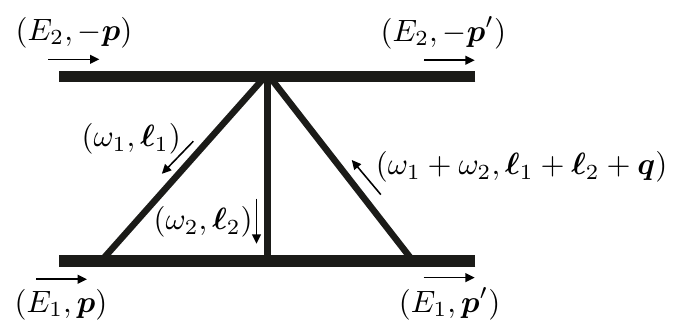
Figure 18 . The double-triangle